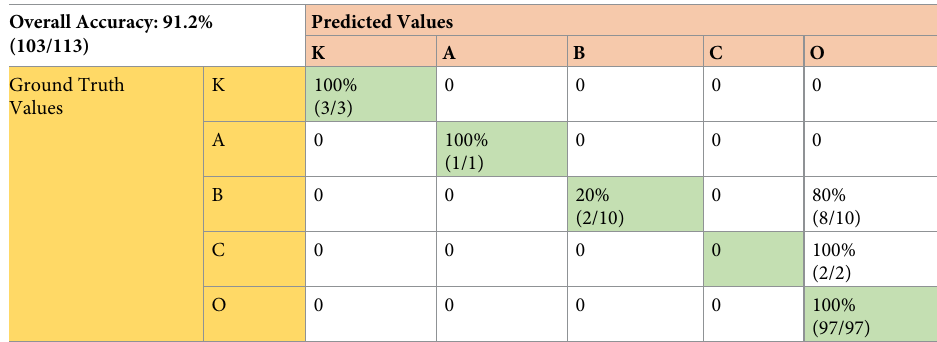
Table 4. Model accuracy of AV crash severity classification